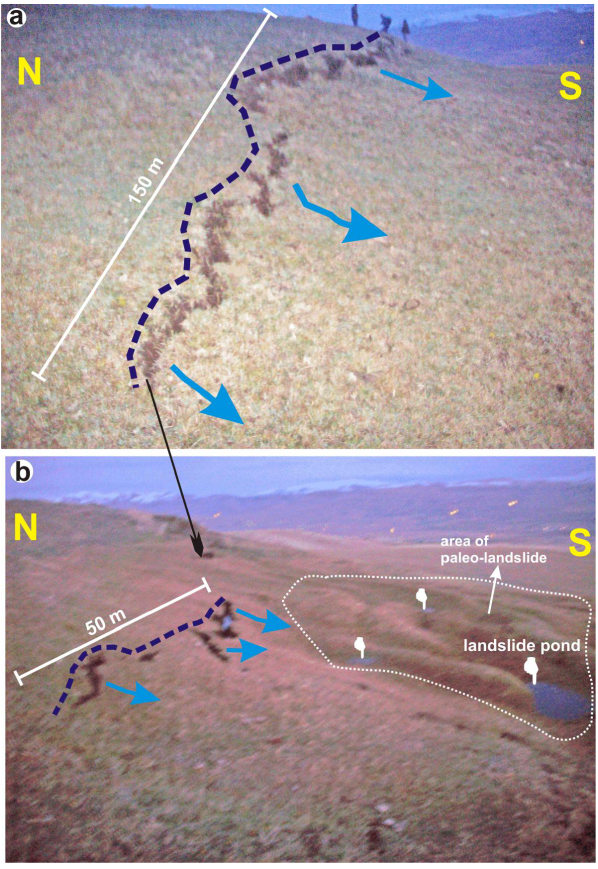
Figure 7. The largest landslide with a 60 cm maximum scarp observed in the south of 2 Fig. 7. The largest landslide with a 60 cm maximum scarp observed Çomaklı a) view of the east section of the landslide b) view of the west section of the 3 in the south of C¸omaklı: (a) view of the east section of the landslide, landslide with a paleo landslide and landslide ponds. 4 (b) view of the west section of the landslide with a paleo-landslide and landslide